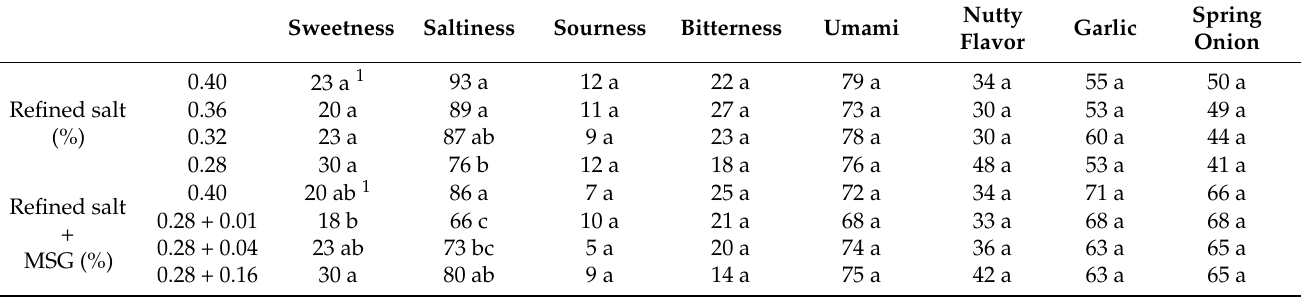
Table 4. RATA counts according to salt or salt with MSG concentrations for soft tofu stew sauce. Sweetness Saltiness Sourness Bitterness Umami